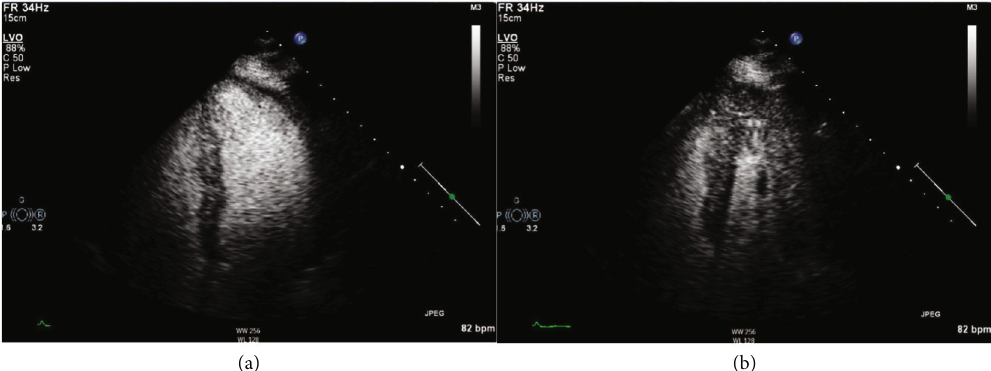
Figure 4: Left ventricular view of TTE with per fl utren contrast demonstrates preserved LV ejection fraction with excellent contractility and the absence of thrombus prior to hospital discharge. (a) Left ventricle during diastole. (b) Left ventricle during